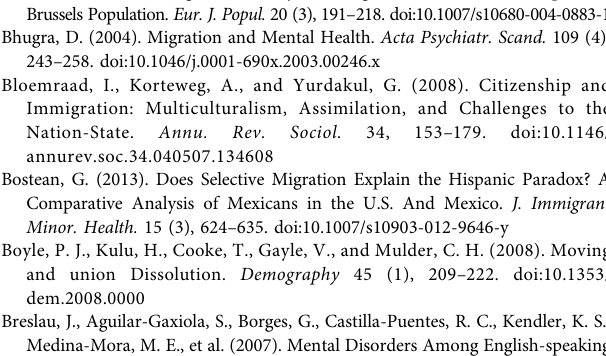
Fixed (SE) Household income loss ( log